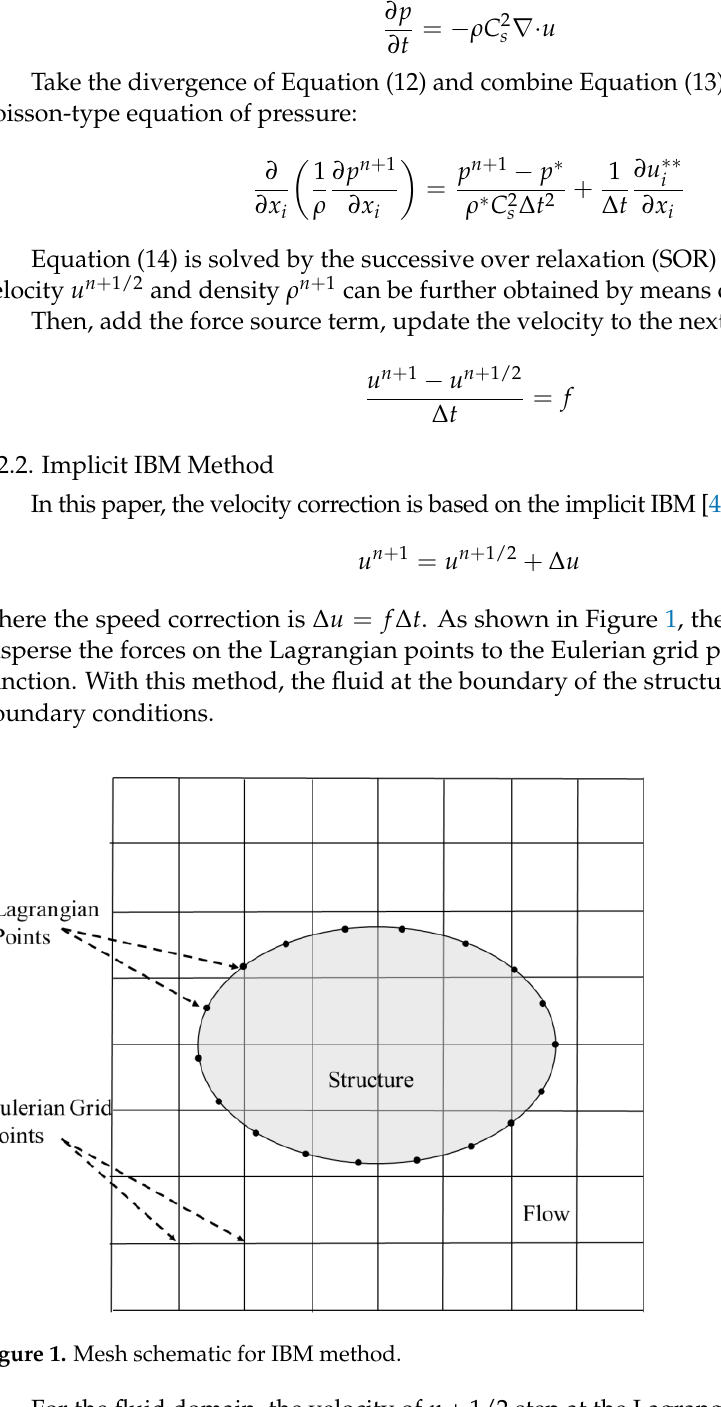
( b ) Figure 2. Sketch of the computational domain ( a ) and the mesh ( b ) for flow past a circular cylinder.